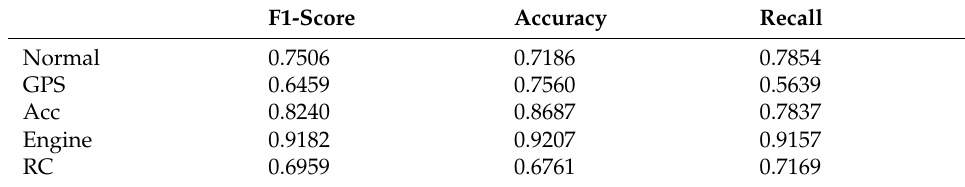
Table 17. Results of RATE data.